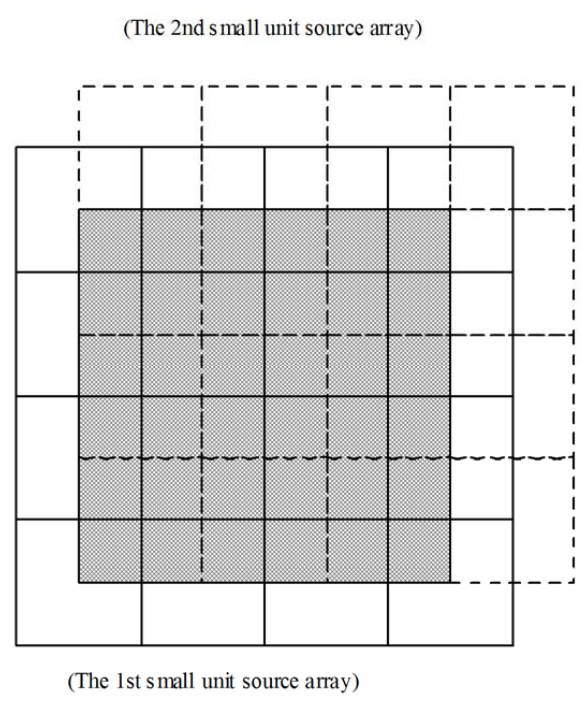
Fig. 2. The sketch of grid shifting. The 1st layer of unit source array is presented in solid lines. The 2nd layer is presented in dashed lines. The shaded area is the final resolution by applying the grid shifting method.